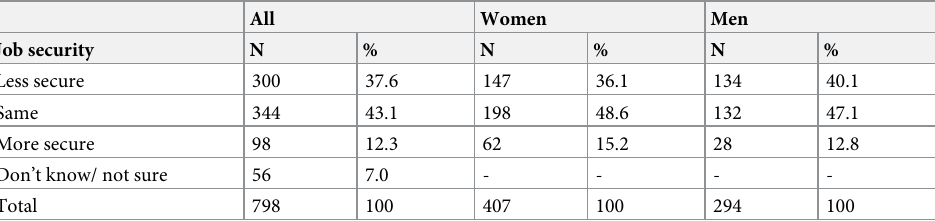
Table 2. How secure do you feel in your employment situation compared to pre-pandemic times? All Women Men Job security N % N % N % Less secure 300 37.6 Same 344 43.1 More secure 98 12.8 Don’t know/ not sure 56 7.0 - - - - Total 798 100 407 100 294